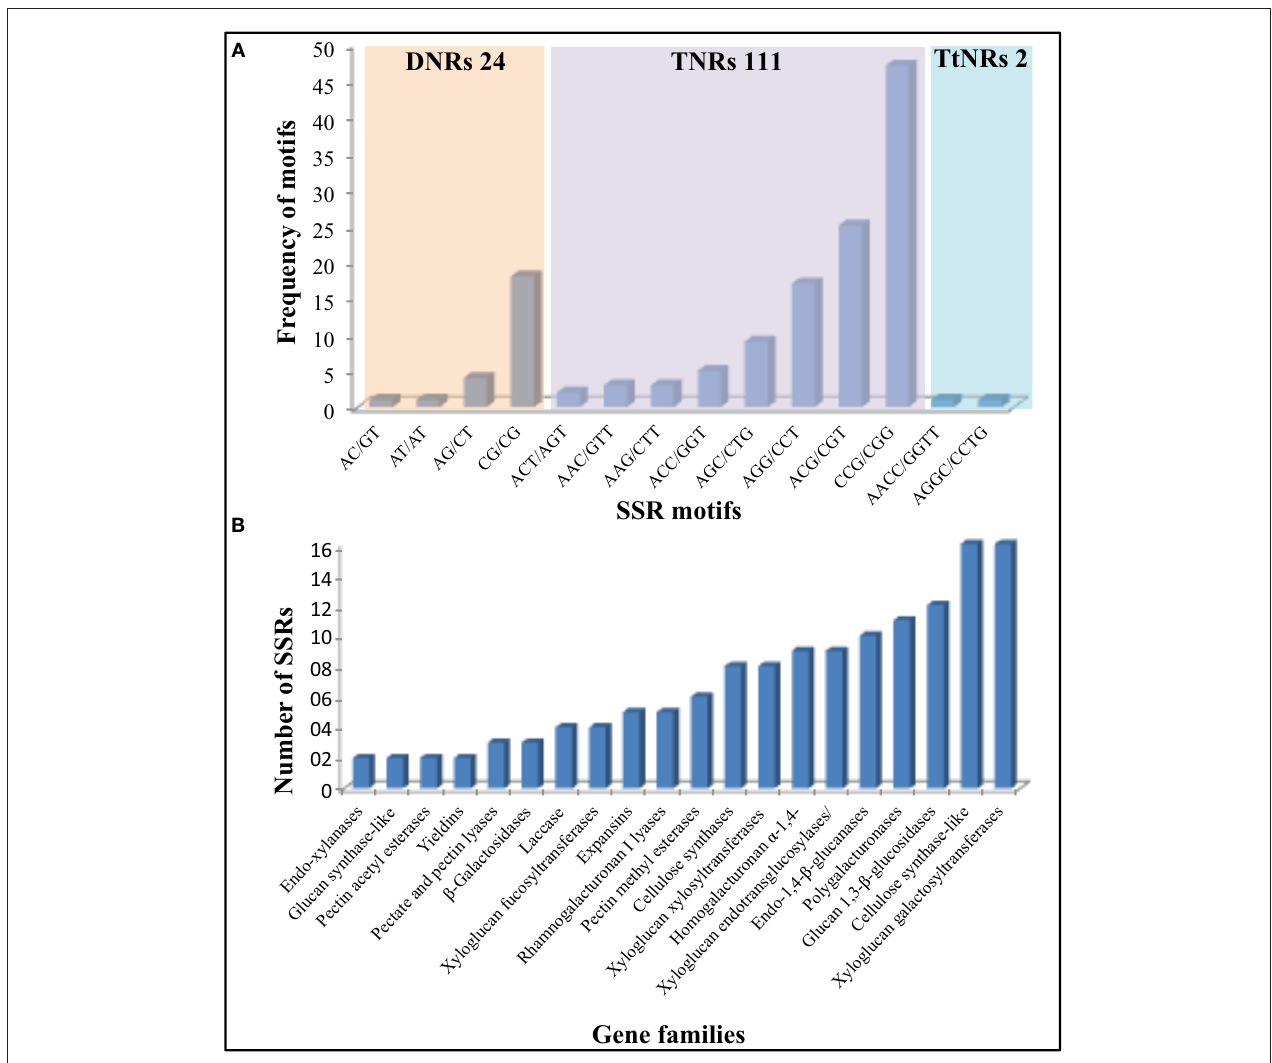
FIGURE 5 | Details of identified SSR markers (137) in 520 cell wall related genes of sorghum. (A) Marker distribution based on number and type of repeat motifs. (B) Gene family wise distribution of identified SSRs markers.